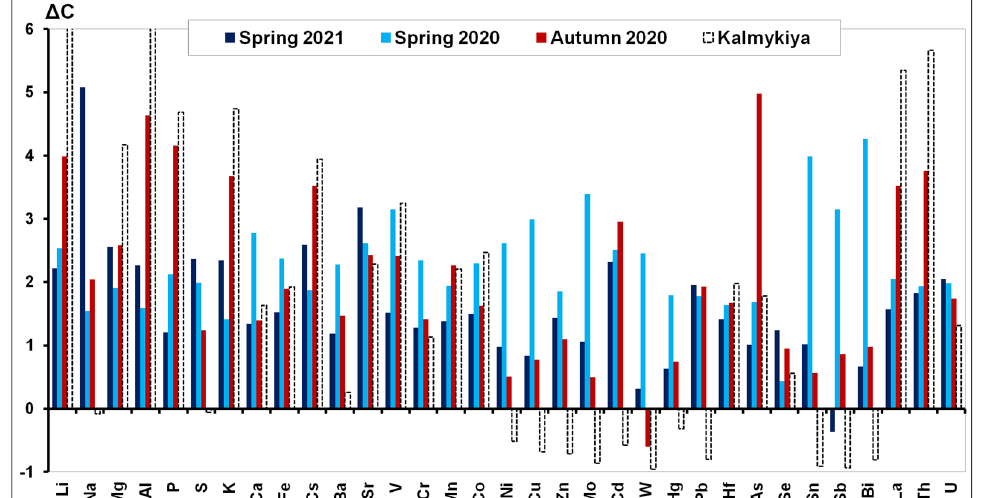
Figure 12. The relative excess of elemental mass concentrations Δ C (formula 2) compared to the background (BG) level (see the text) during three episodes, as well the relative excess of elemental concentration for Kalmykia arid aerosol [27] compared to the background elemental concentrations for autumn 2020 in Moscow.